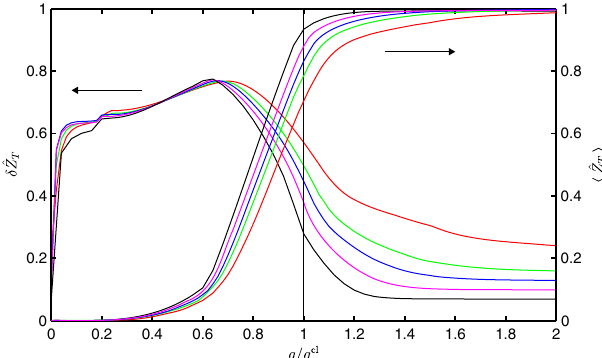
FIG. 2. Time-averaged imbalance and quantum fluctuations of the imbalance. The time-averaged imbalance for varying g=g cl , as c well as its quantum fluctuations (mean squared fluctuations), for coherent states of five different mean photon numbers (red, 20; green, 40; blue, 60; magenta, 100; black, 200). Here, the total imbalance Z is the difference in the number of excitations on T each side (photon plus qubit excitation), normalized by the total excitations N in the system. The classical prediction puts the T ¼ 1 . The quantum fluctuations are largest in transition at g=g cl c the classically delocalized regime, and lead to a renormalization of the expected quantum value of the critical coupling g qu c downwards (i.e., requiring smaller coupling to observe localiza- tion if the total excitation number is held fixed), and hence relocating the critical photon number N qu c upwards. This is reflected in the buildup of a finite imbalance in the region where the classical analysis predicts no net imbalance, which is, therefore, a quantum localized regime. We also observe that as the number of excitations in the system is increased, the transition gets sharper, suggesting the thermodynamic limit for this spa- tially finite system is given by the limit of large excitation